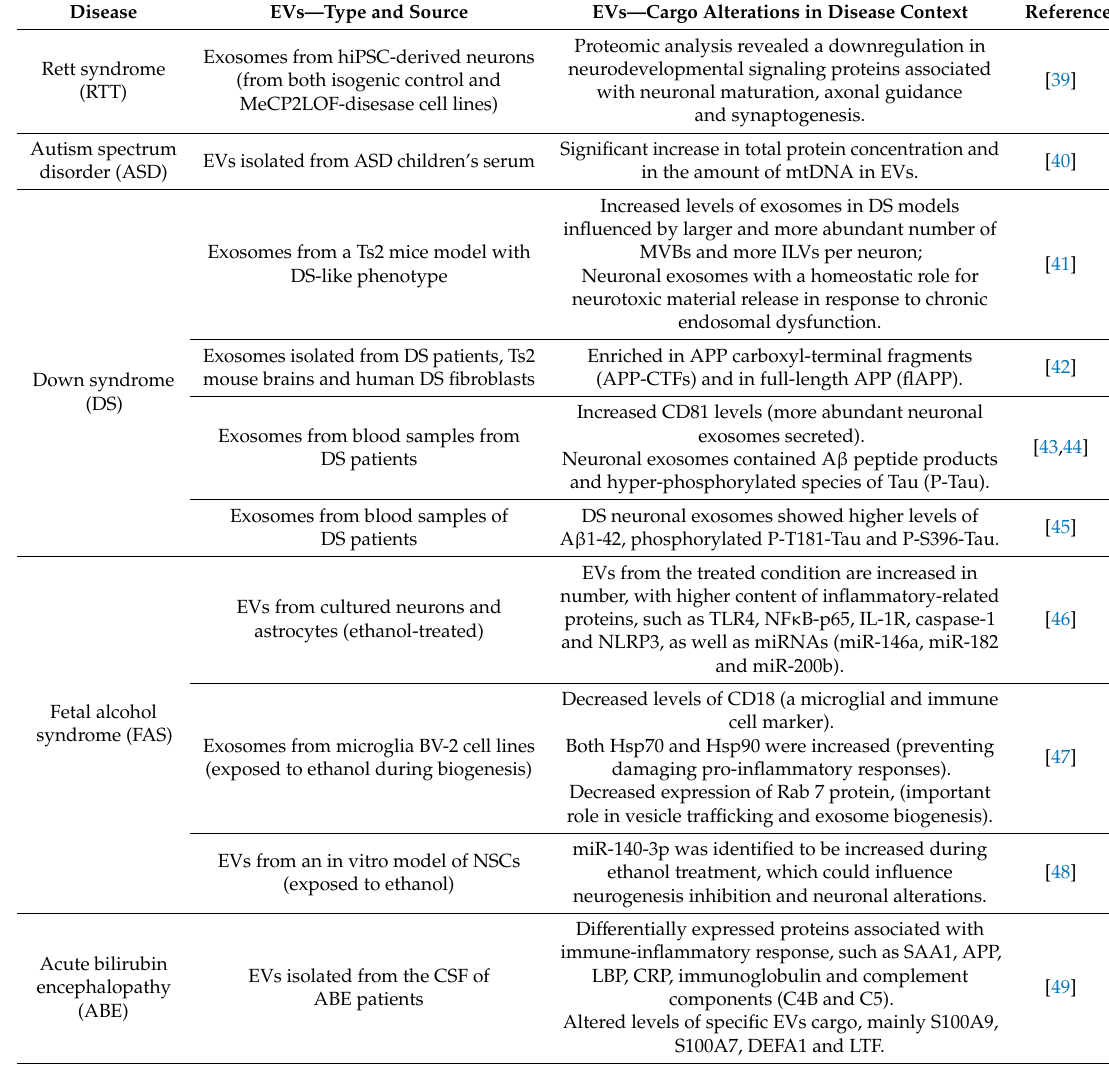
Table 1. EV cargo alterations associated with various models of human neurodevelopmental